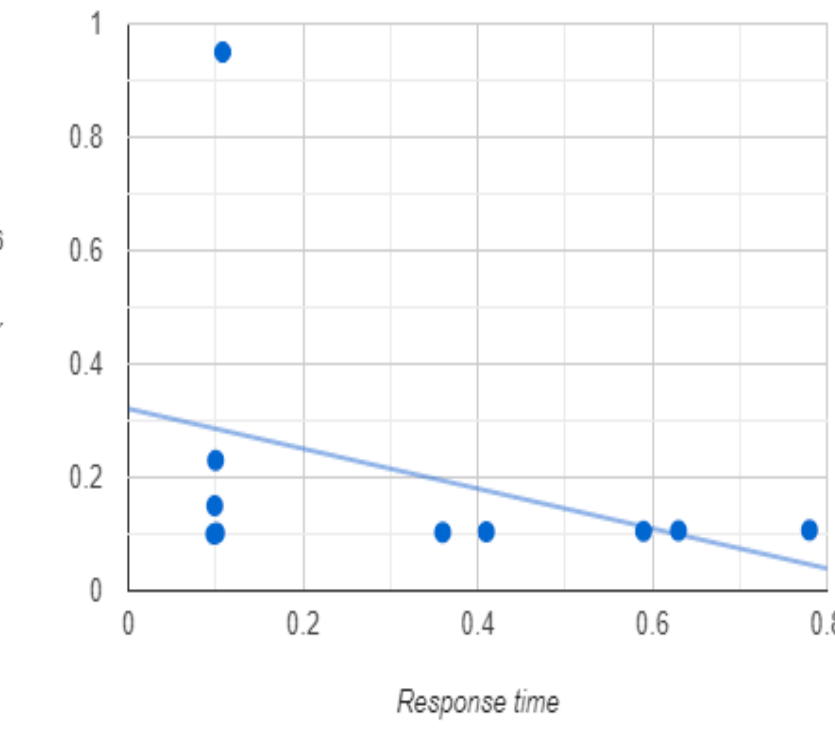
Figure 5. Traffic load against response time.